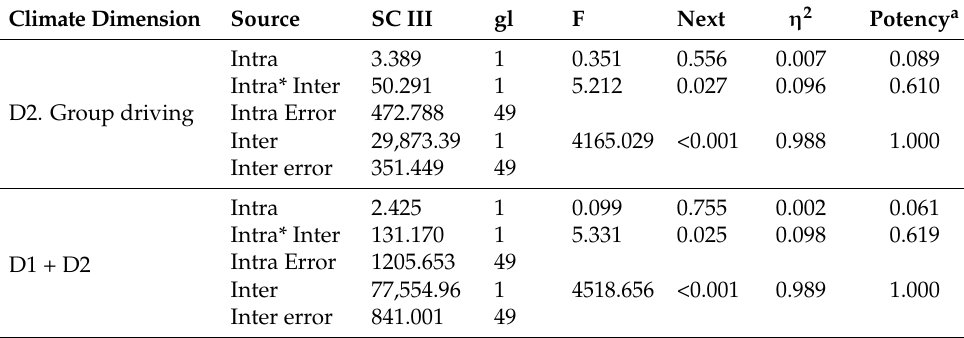
Table 5. Summary of intra-subject univariate ANOVA.